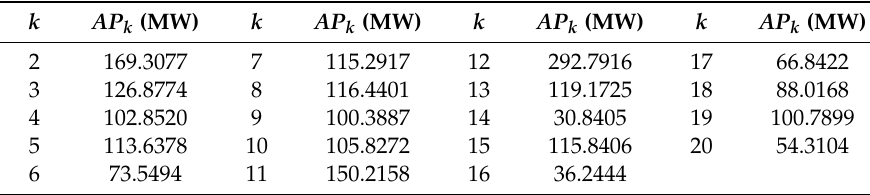
Table A4. The best solution for system 4 found by